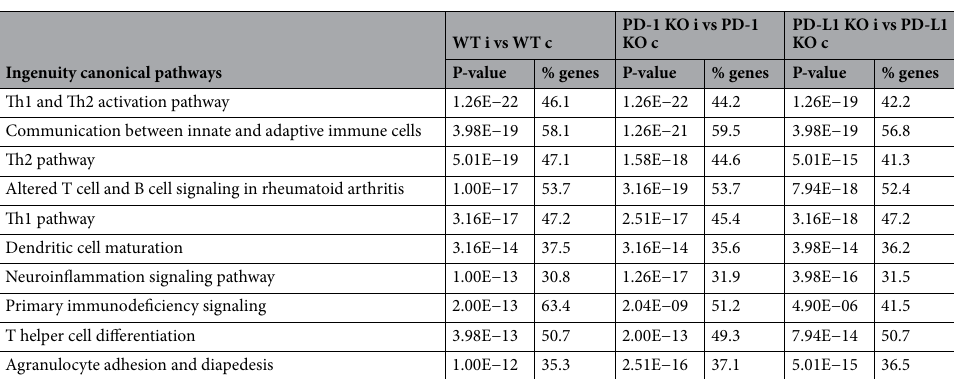
Table 1. The most significantly enriched canonical pathways compared between infected wild-type lungs and uninfected wild-type lungs 60 days after MAC infection. WT i wild-type lungs infected with MAC